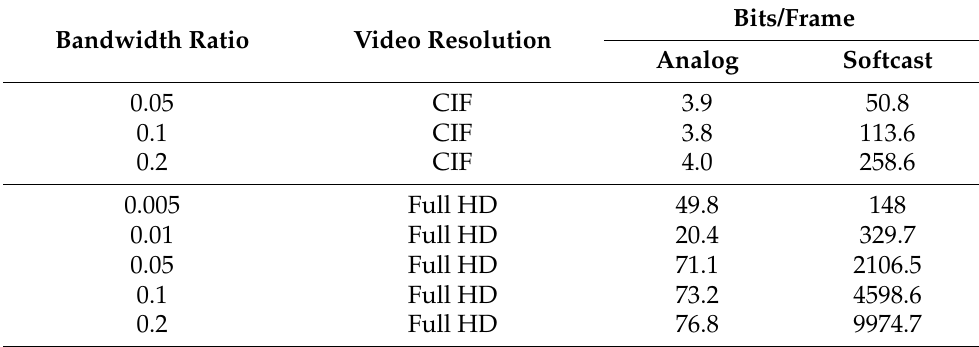
Table 2. Amount of metadata required by Softcast and the proposed JSCC-Cast considering the best combination of 2D and 3D-DCT (situation demanding the highest amount of